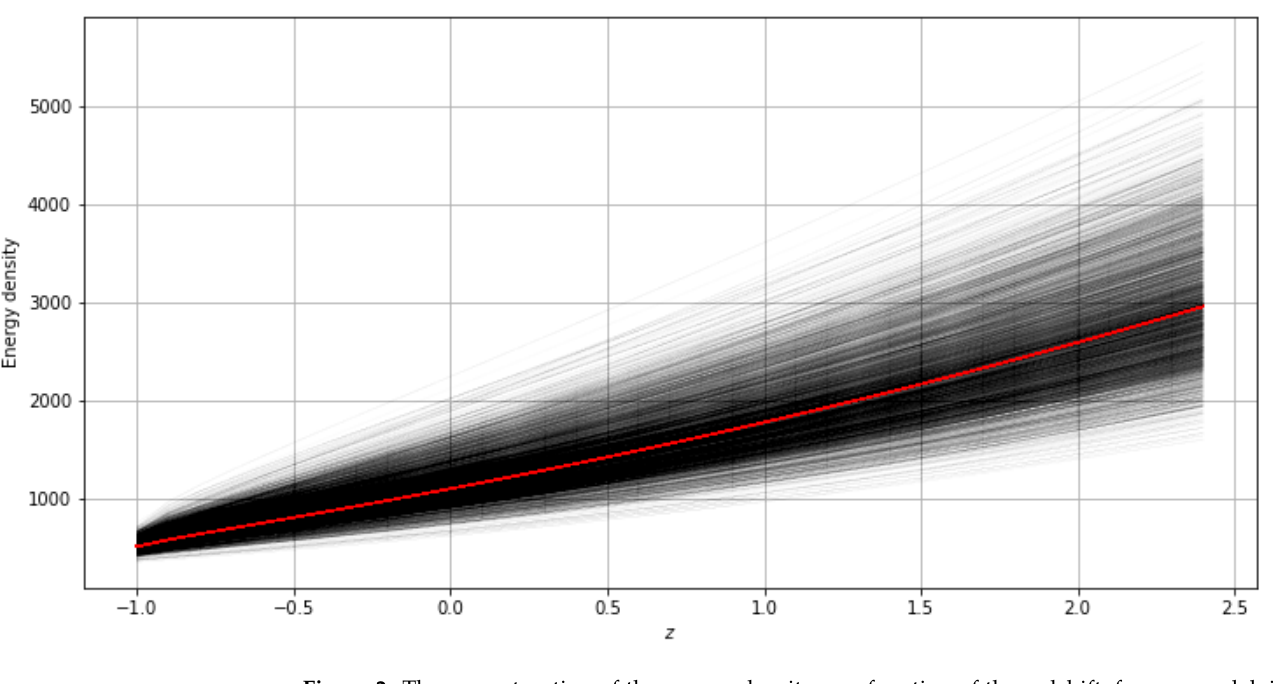
Figure 2. The reconstruction of the energy density as a function of the redshift, for our model, is presented for 7500 samples, which are reproduced by re-sampling the chains through emcee . We plot all the obtained curves, alongside the curve corresponding to the best fit of the parameters (red curve).